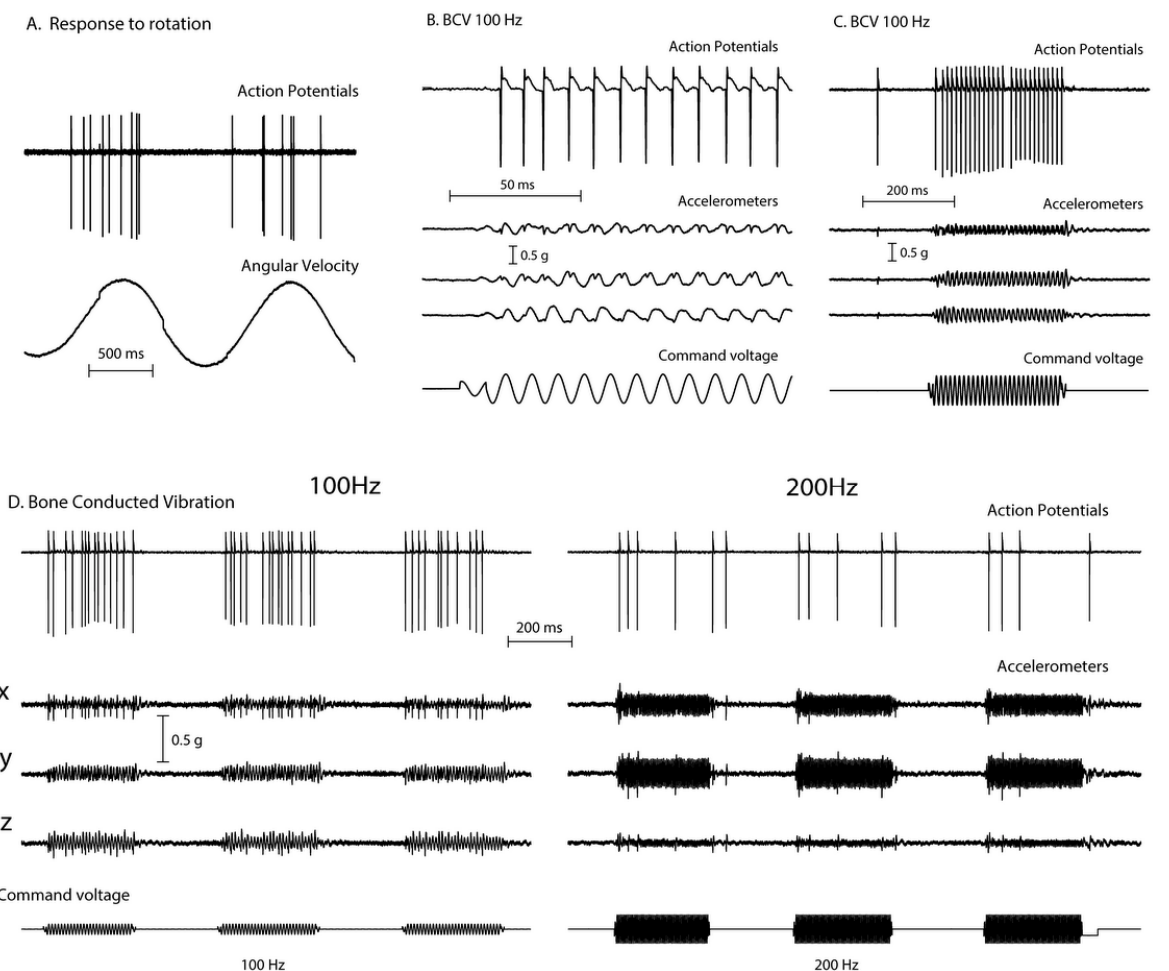
Figure 2. The responses (action potentials) of a primary semicircular canal neuron to low frequency skull vibration. ( A ) Responses to angular acceleration, demonstrating that this is a semicircular canal neuron. ( B ) In response to 100 Hz vibration, the neuron fires one action potential per cycle and it is phase locked to the stimulus, as shown by the small spikes in the accelerometer records and the very even spacing of action potentials in ( C ). However, if frequency is increased the neural response decreases ( D ) even when the vibration intensity is increased (as shown by the smaller response at 200 Hz compared to 100 Hz). Reproduced from [2] with permission of Wolters Kluwer Health.